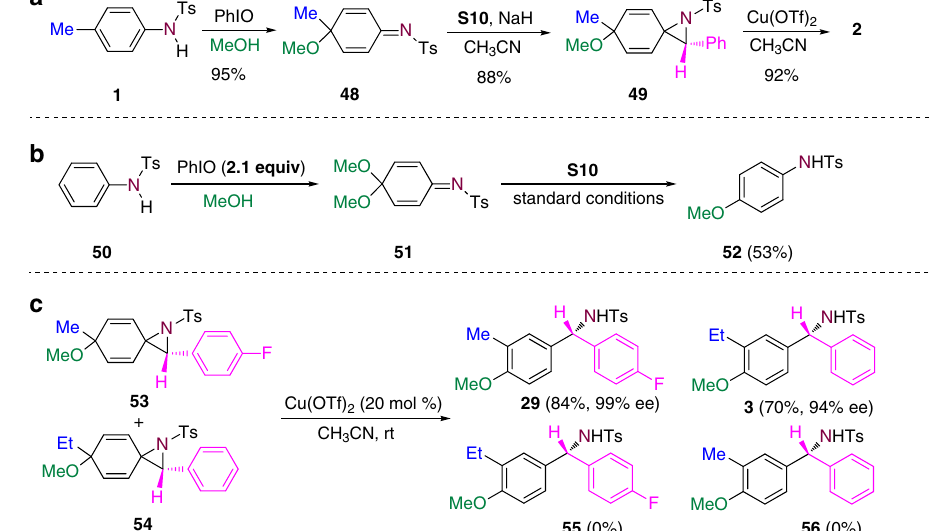
Fig. 6 The mechanistic study. a Reactions of the isolated intermediates. b Reaction of unsubstituted benzenamine under the standard conditions. c Reaction of a mixture of two aziridination intermediates.